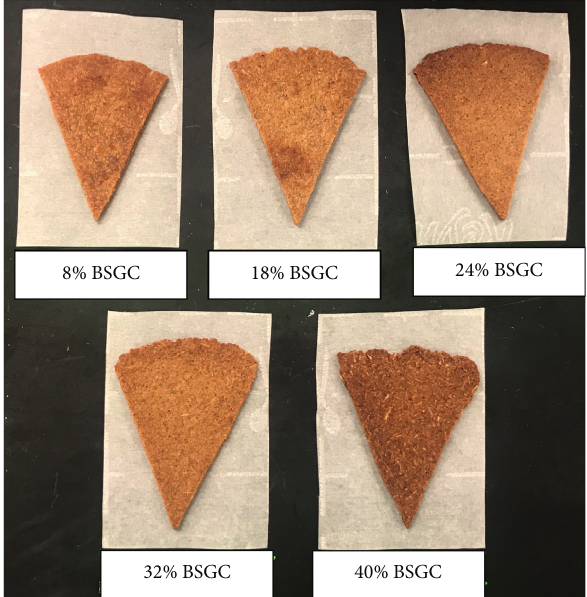
Figure 3: Brewer’s spent grain chip samples with varying levels of inclusion of